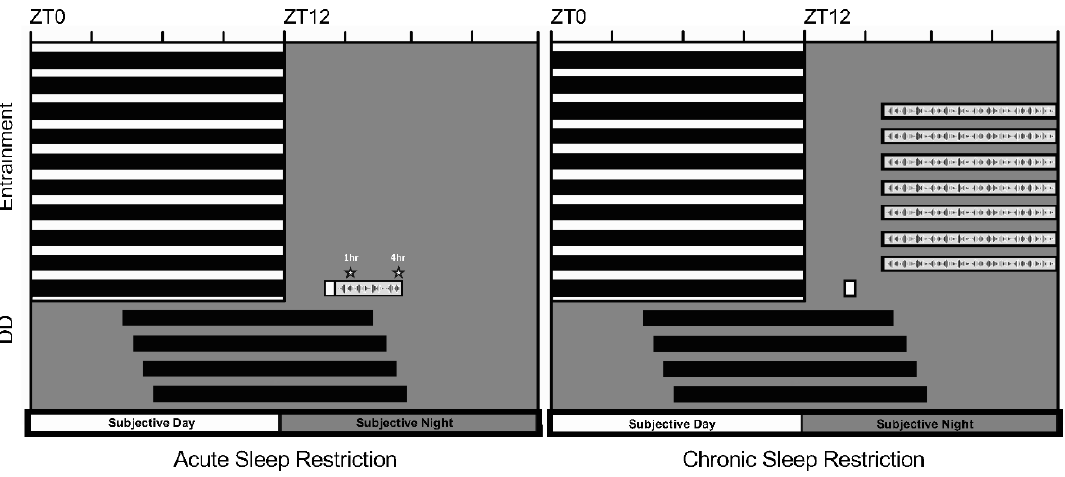
Figure 1. Overview of sleep restriction protocols. ( Left panel ) Independent groups of flies were sleep-restricted via mechanical perturbation for 1 or 4 h immediately following exposure to a 15-min broadspectrum light pulse (950 lux) at ZT14, 2 h after lights-off (19.00 MST) on the last day of entrainment to a 12:12 LD cycle. Phase shifts were quantified after free-running in constant darkness (DD) for 3 – 4 days. ( Right panel ) A separate group of animals was pulsed at ZT14 (15 min, 950 lux) after undergoing a chronic sleep restriction protocol (8 out of 12 h each night) for 7 consecutive nights. Once pulsed, the animals remained undisturbed for the rest of the experiment. Animals were demonstrably active during the period in which mechanical perturba- tion was applied (and remained so for approximately 2 h after the gentle shaking had stopped; Figure 2B); however, the average delay shift observed in rested versus unrested flies was not statistically different (mean ± SEM; light pulse alone, 4.83 ± 0.19 h; light pulse and 1 h sleep deprivation, 5.43 ± 0.30 h; light pulse and 4 h sleep deprivation, 5.21 ± 0.29 h; F 3,113 = 1.595, p = 0.1946; representative actograms provided in Figure 2C). Results were (Figure 2D,E; Dunnett’s multiple comparisons test, p > 0.99). The magnitude of delay shifts recorded in animals enduring several nights of limited sleep opportunity (4.80 ± 0.17 h) were not distinguishable from either those experiencing short-term sleep restriction or those with a normal sleep history before and after the light